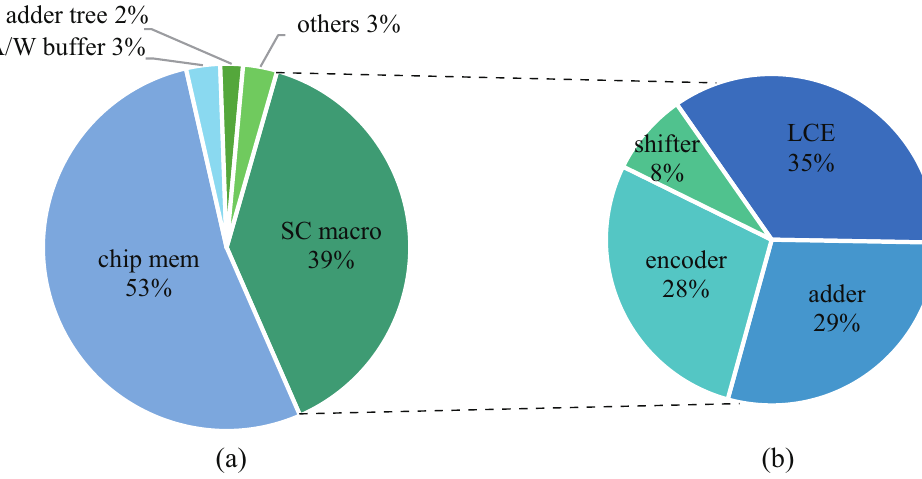
Figure 12. Area breakdown. ( a ) Area breakdown of SCA architecture. ( b ) Area breakdown of SC